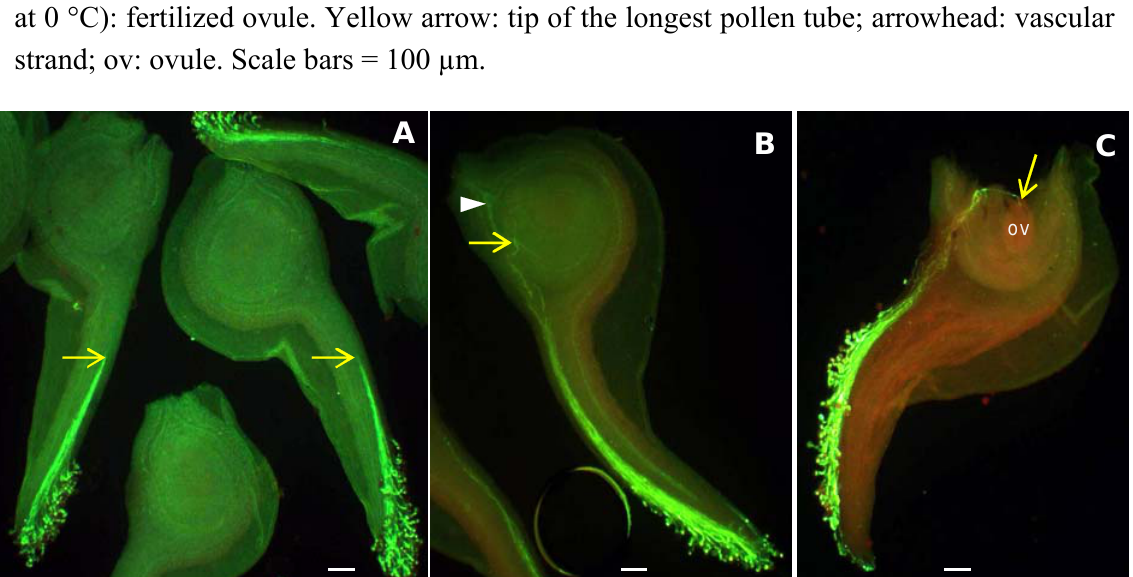
Figure 3. Pollen tube growth in R. glacialis during the cold snap experiment in